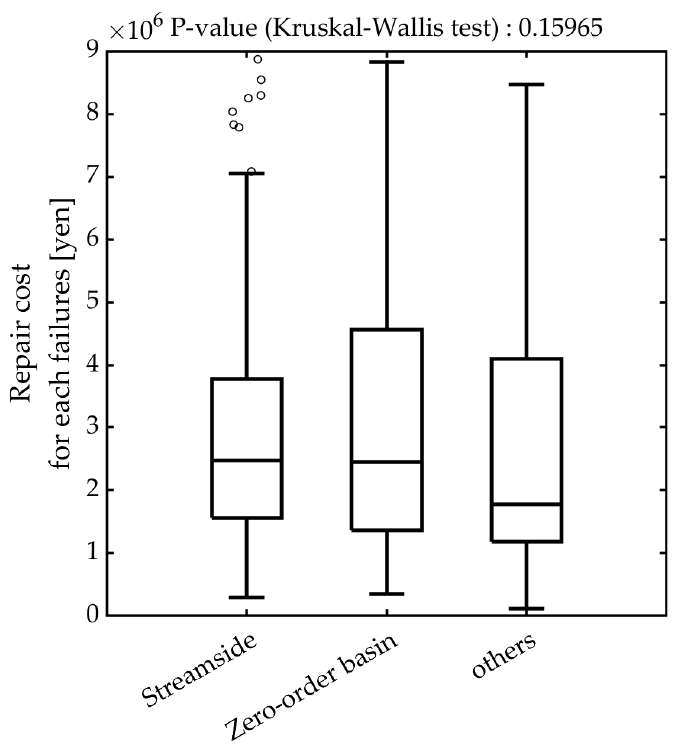
Figure 10. Repair cost by risk category for each area damaged by failure. The line in each box represents the median of the sample; the upper and lower ends of each box represent the upper and lower quartiles, respectively.